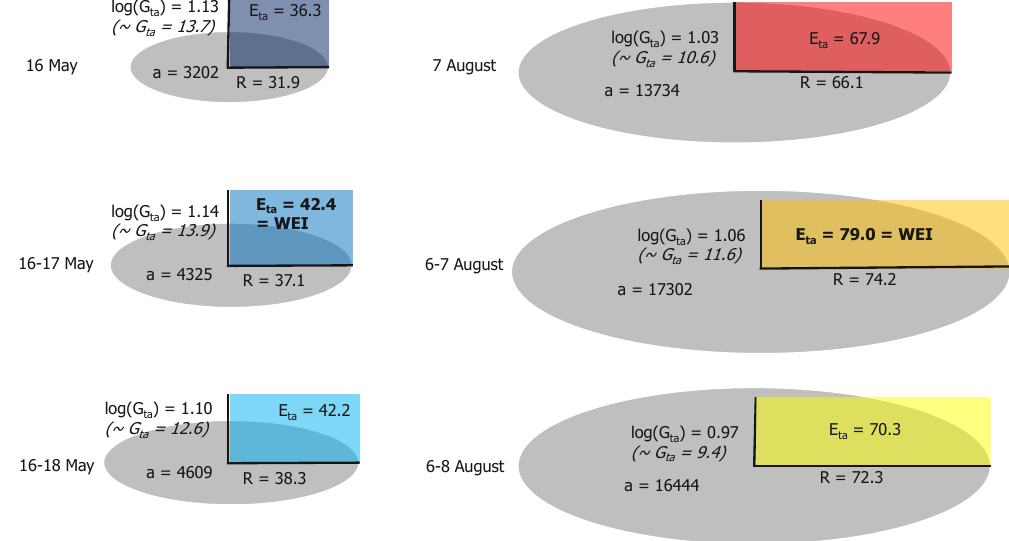
Fig. 7. Demonstration of E ta and WEI values as products of log( G ta ) (the common logarithm of the geometric mean of return periods) and R (radius of the circle area equivalent to the considered area a) . Units are as follows: R [km], a [km 2 ], G ta [yr], E ta and WEI [log(yr)km].